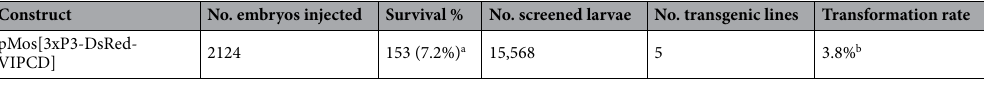
Table 1. Microinjection of the pMos[3xP3-DsRed-VIPCD] construct into Ae. aegypti HWE preblastoderm embryos. a Percentage of injected embryos that hatched into adults. b Estimated percentage of independently transformed lines generated per fertile adult (assuming ~ 50%